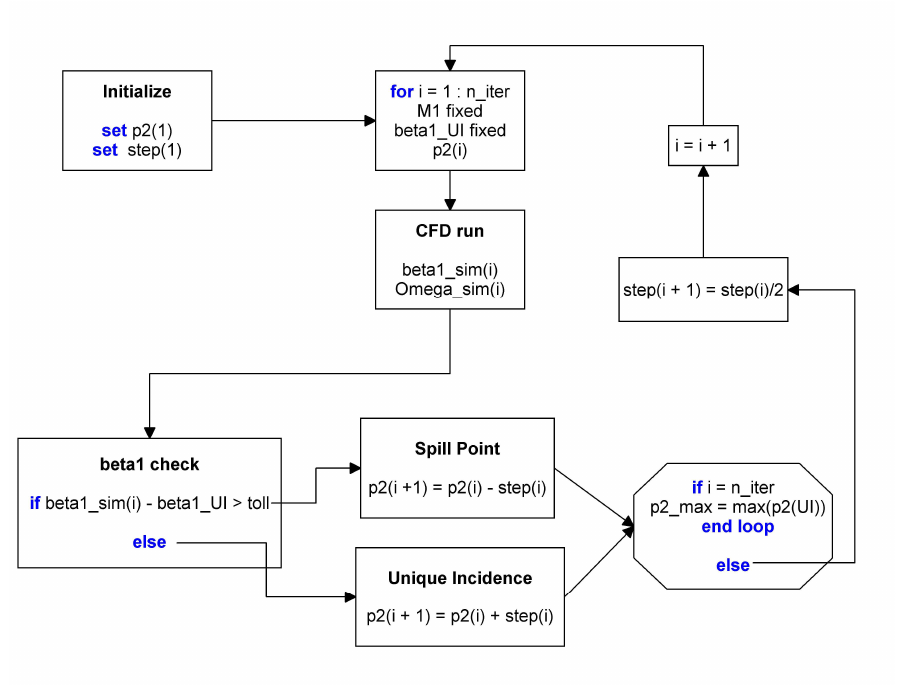
Figure 8. Maximum pressure ratio searching